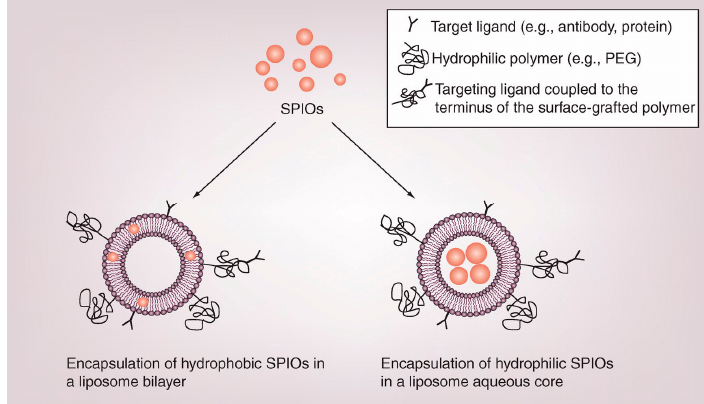
Figure 6. Diagram of superparamagnetic iron oxide nanoparticles (SPIONs) encapsulated by liposome. Reproduced from “Liposome-nanoparticles hybrids for multimodal diagnostic and therapeutic applications”, with permission from Future Medicine Ltd.,